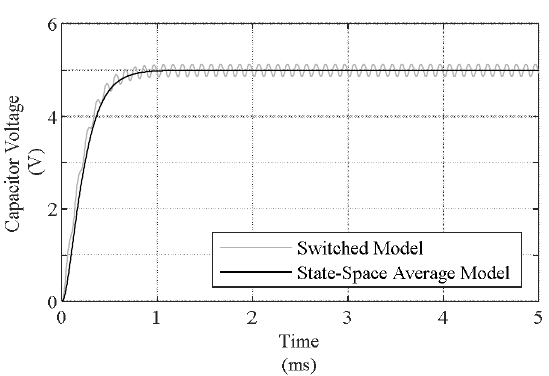
Fig. 5. Transfer functions’ response related to the state-space and switched